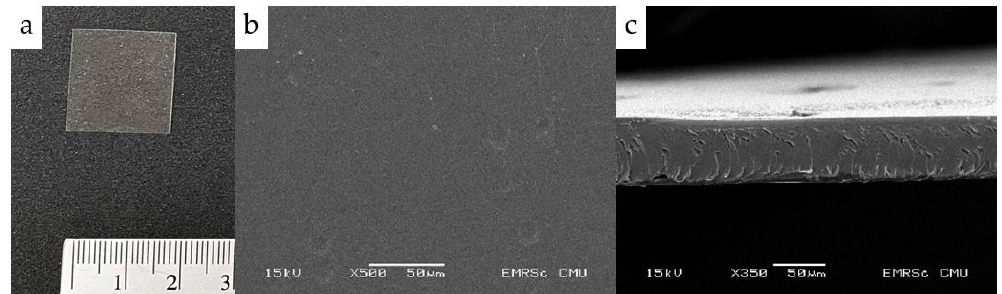
Figure 3. NCT fast dissolving film visual image ( a ); SEM images of the surface ( b ) and cross-section ( c ) at 500× and 350× magnification, respectively.